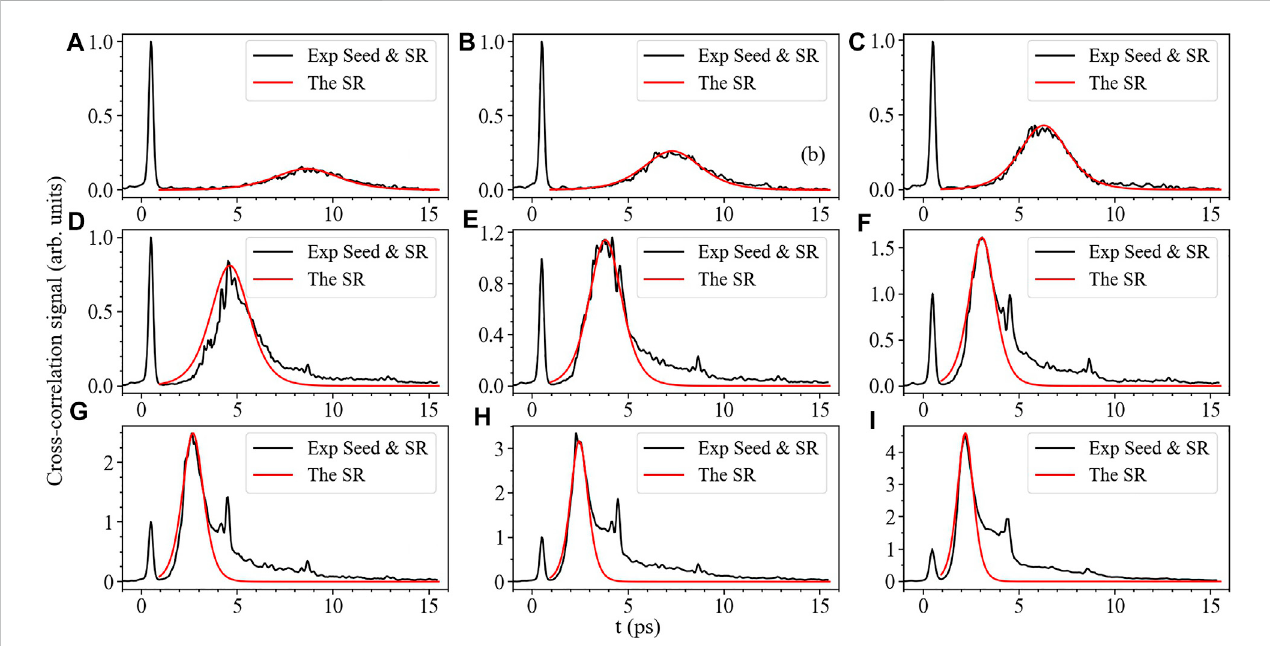
FIGURE 3 Comparisons of the experimental data and theoretical predictions for the temporal pro fi le of the 391-nm lasing emission with different gas pressure of (A) 6 mbar, (B) 7 mbar, (C) 8 mbar, (D) 10 mbar, (E) 12 mbar, (F) 14 mbar, (G) 16 mbar, (H) 18 mbar and (I) 20 mbar, respectively.